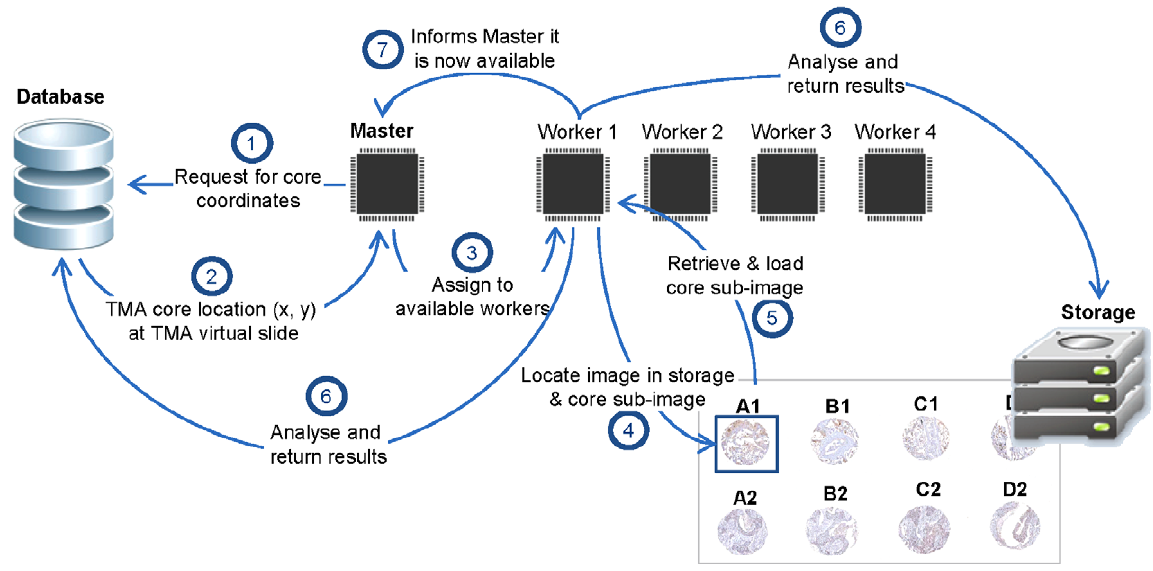
Fig. 2. Diagram illustrating the centralised dynamic load balancing approach for parallelise image processing tasks. The steps are numbered to illustrate the workflow. (Colours are visible in the online version of the article; http://dx.doi.org/10.3233/ACP-CLO-2010-0551.) Texture features are widely used in tissue